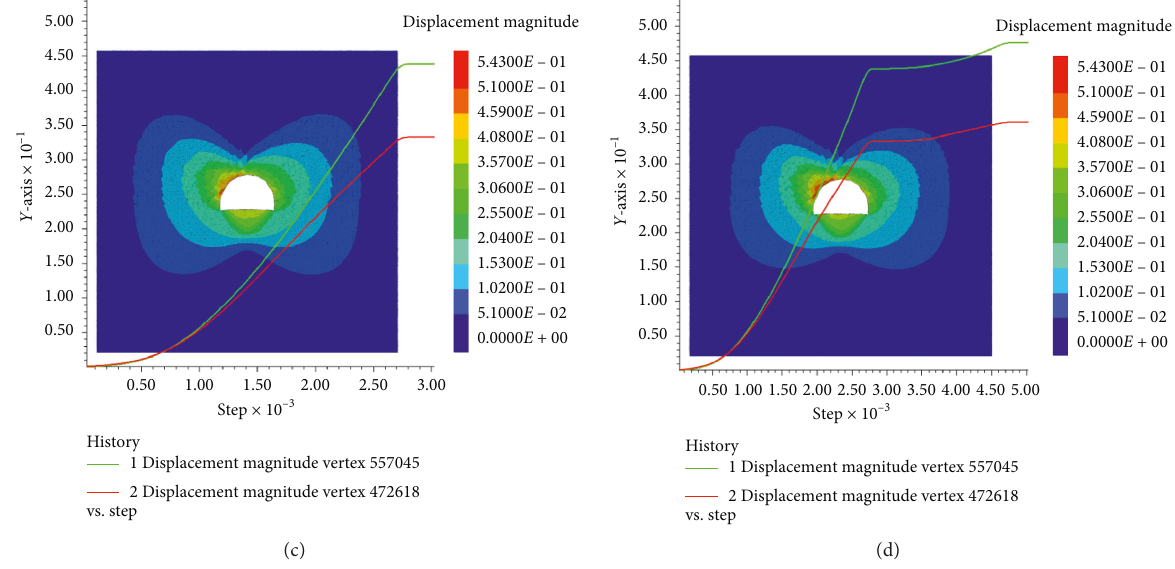
Figure 15: Surrounding rock displacement nephrogram with the steel anchor support. (a) Step 1000, (b) step 2000, (c) step 2700, and (d) step